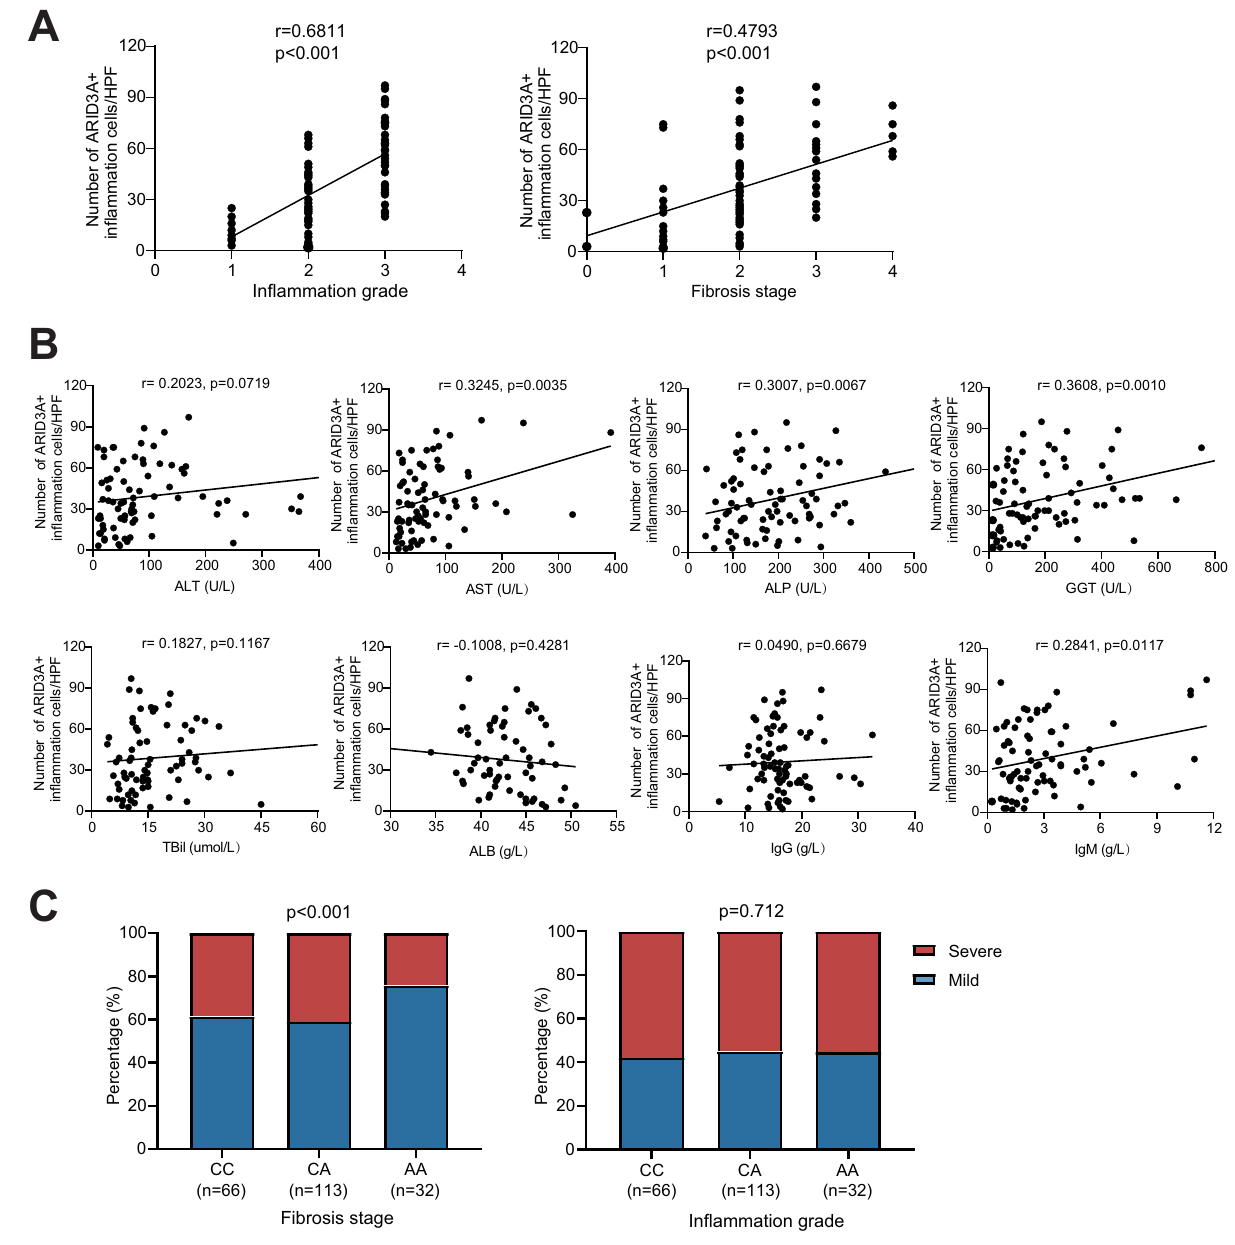
Fig.7| ARID3A expressionandrs2238574genotypesareassociatedwithdisease severity. A Association of the numbers of hepatic ARID3A positive in fl ammation cells with hepatic in fl ammatory degrees (left) and fi brosis stages (right) in PBC patients. B Association of the numbers of hepatic ARID3A positive in fl ammation cells with serum ALT, AST, GGT, ALP, TBil, ALB, IgG and IgM levels. Association analysis are performed using Pearson ’ s correlation. C Association of rs2238574